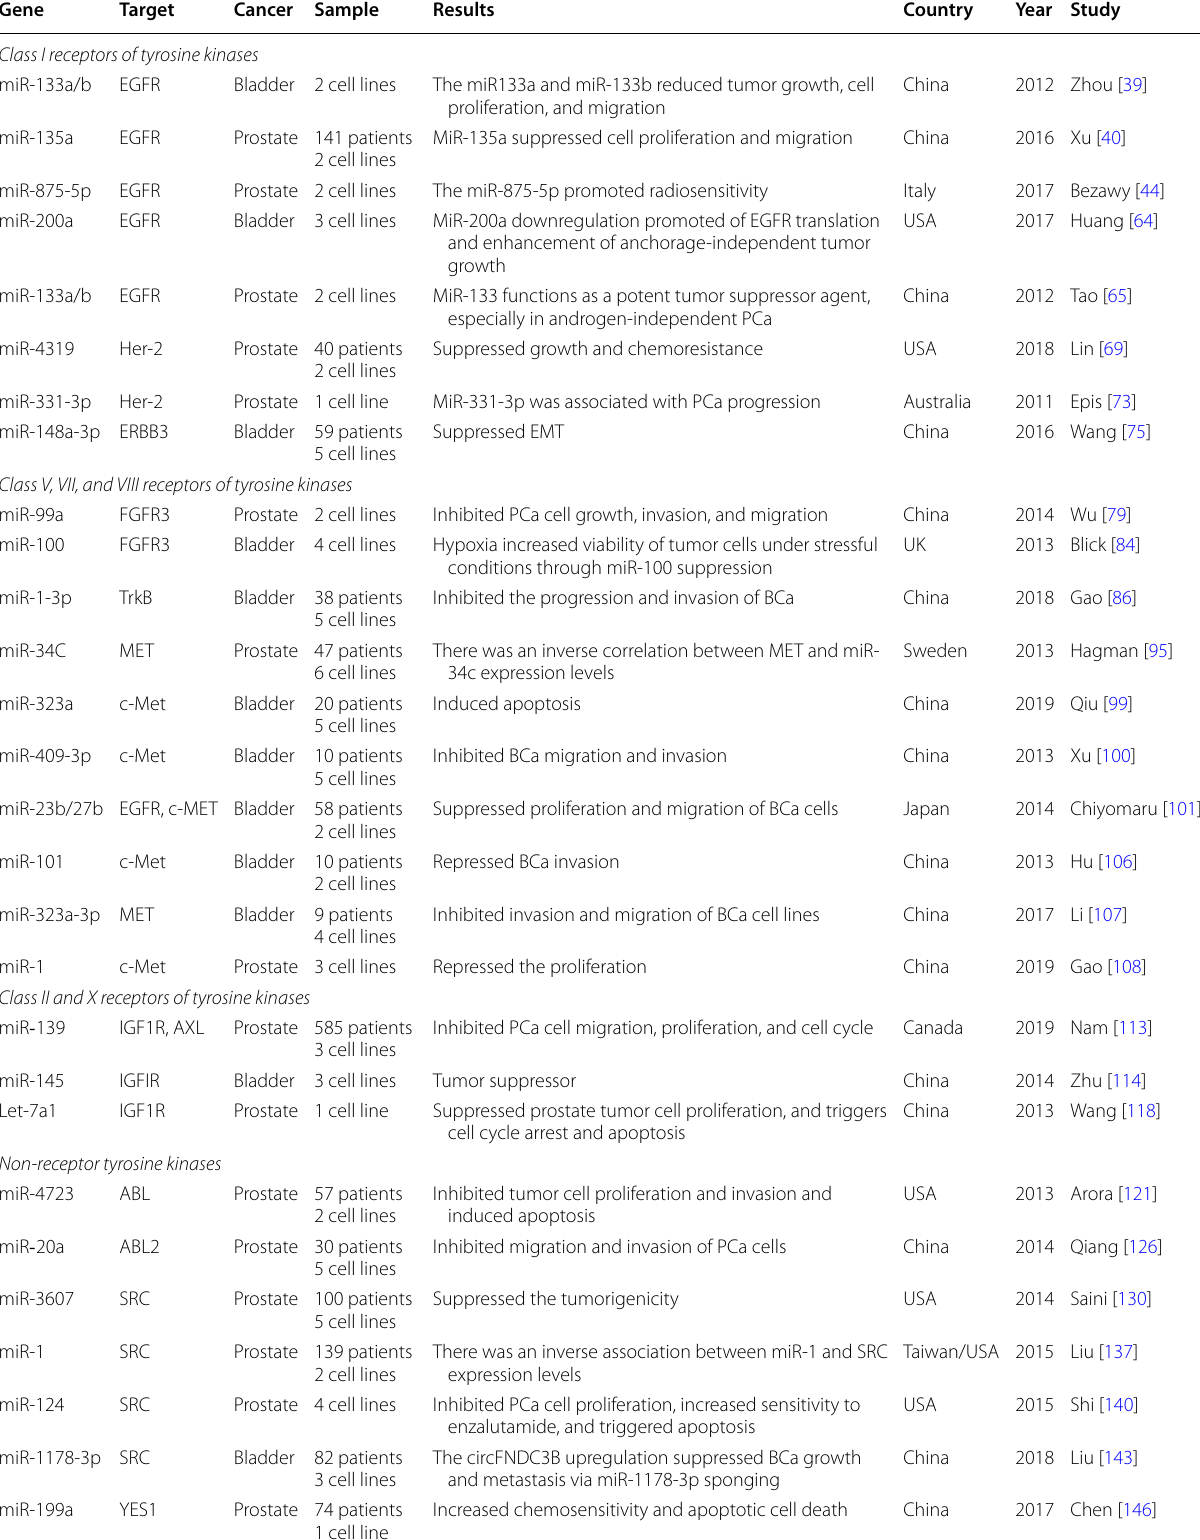
Table 1 All of the miRNAs which have been reported to regulate the protein kinases in bladder and prostate cancers